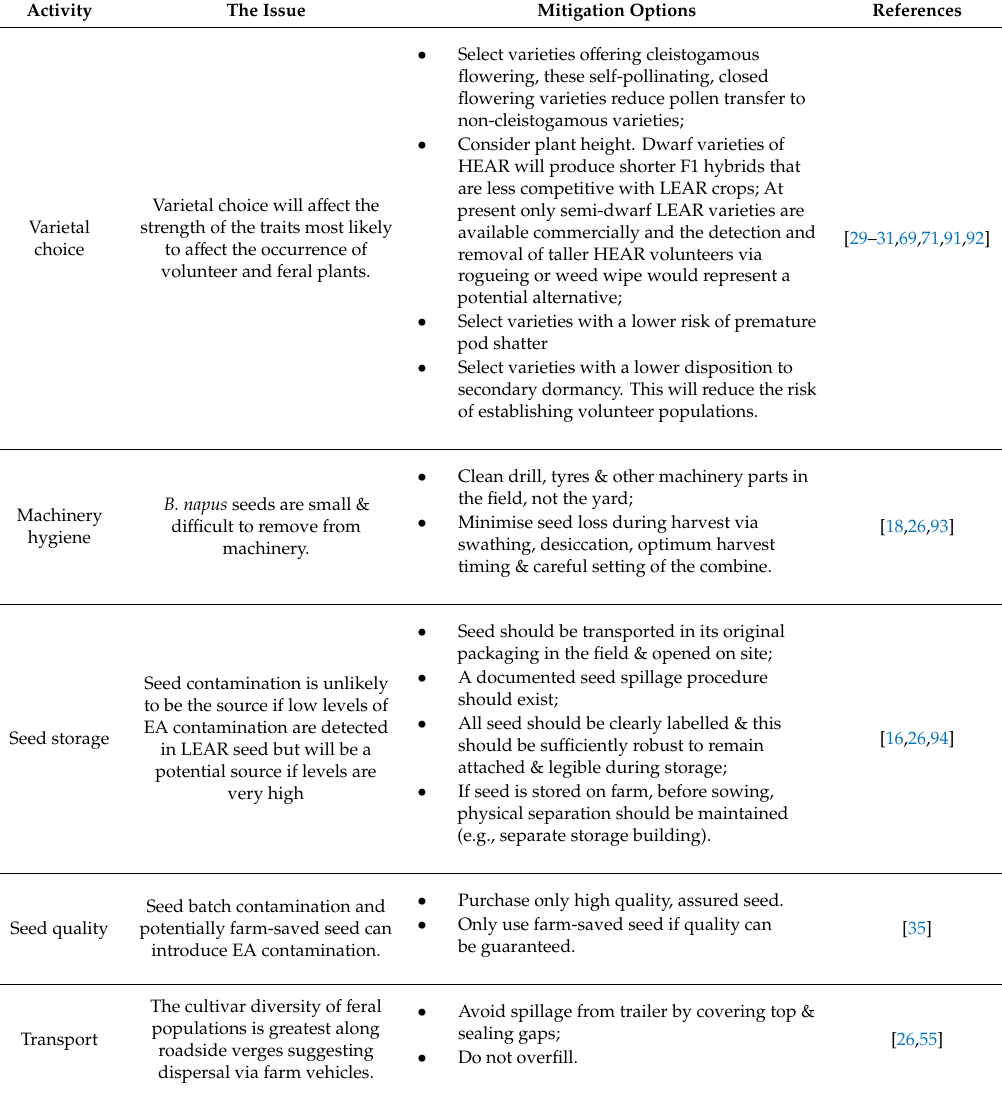
Table 2. Post-harvest storage, transport and processing mitigation